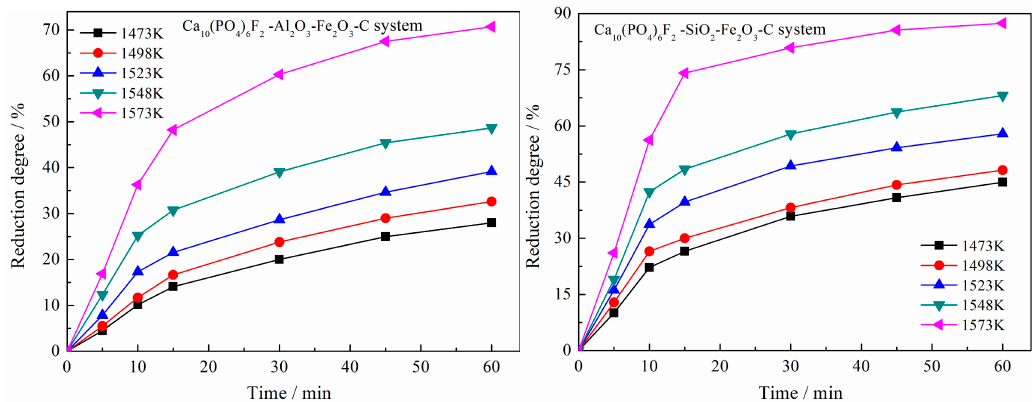
Figure 7. Effect of reduction time on the reduction degree of fluorapatite in systems of Ca 10 (PO 4 ) 6 F 2 – Figure